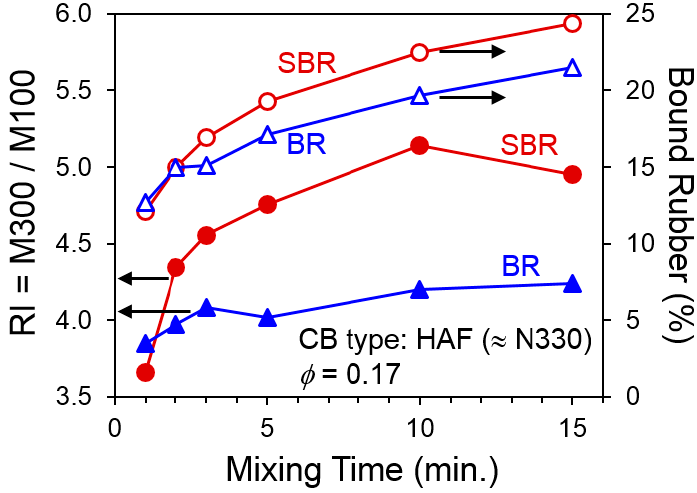
Figure 3. Reinforcement index and bound rubber versus mixing time for CB-filled SBR and BR compounds. Data replotted from Brennan, Jermyn, and Boonstra [7].